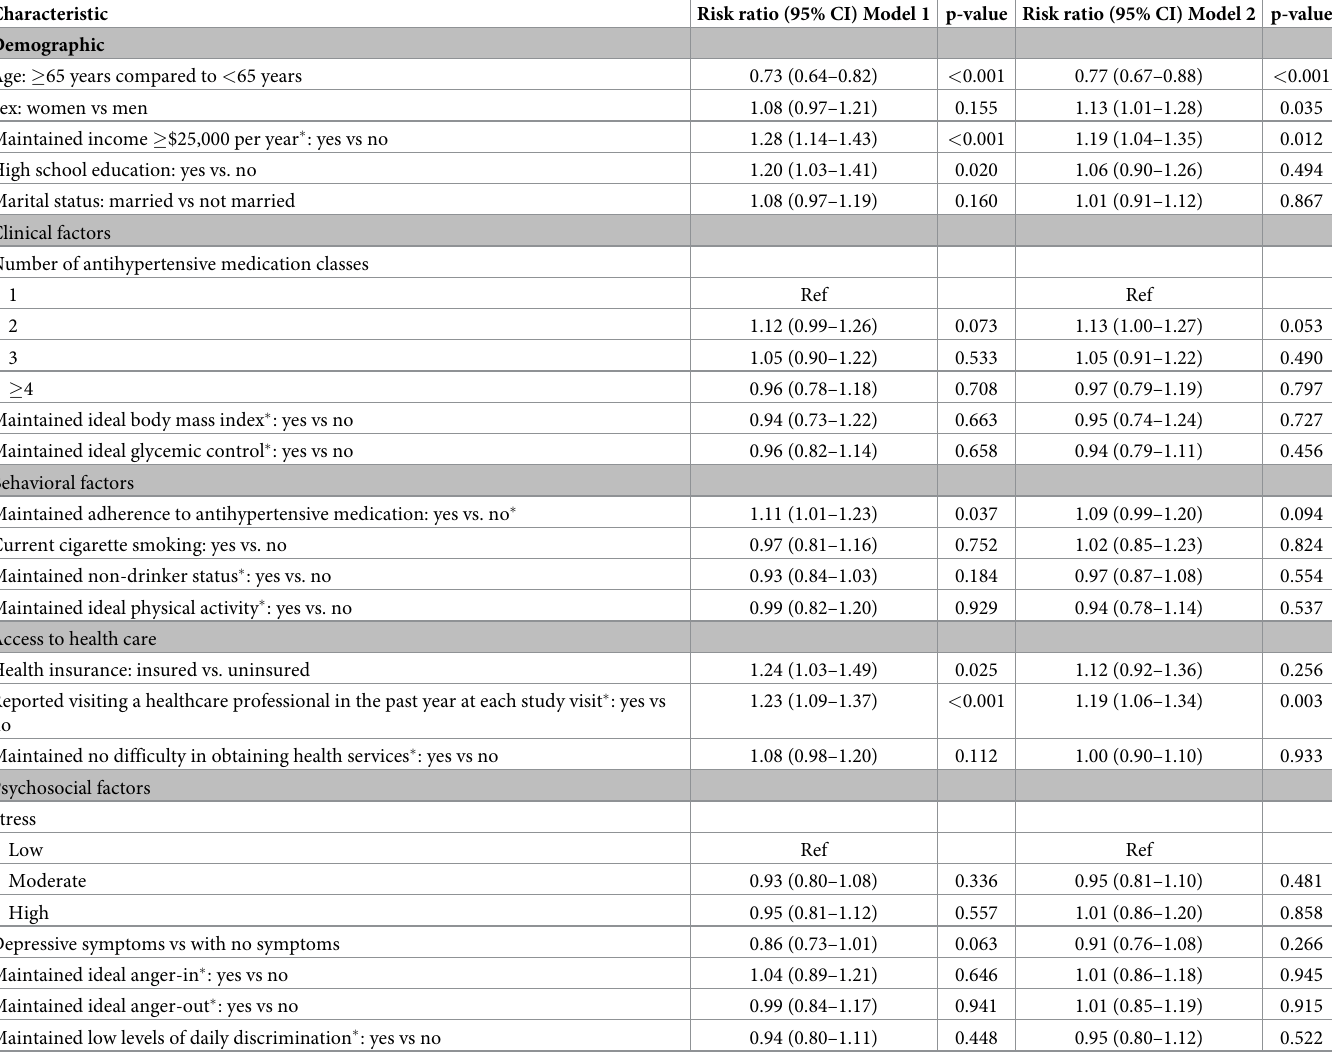
Table 3. Adjusted risk ratios for persistent blood pressure control among participants taking antihypertensive medication (n = 1,604).